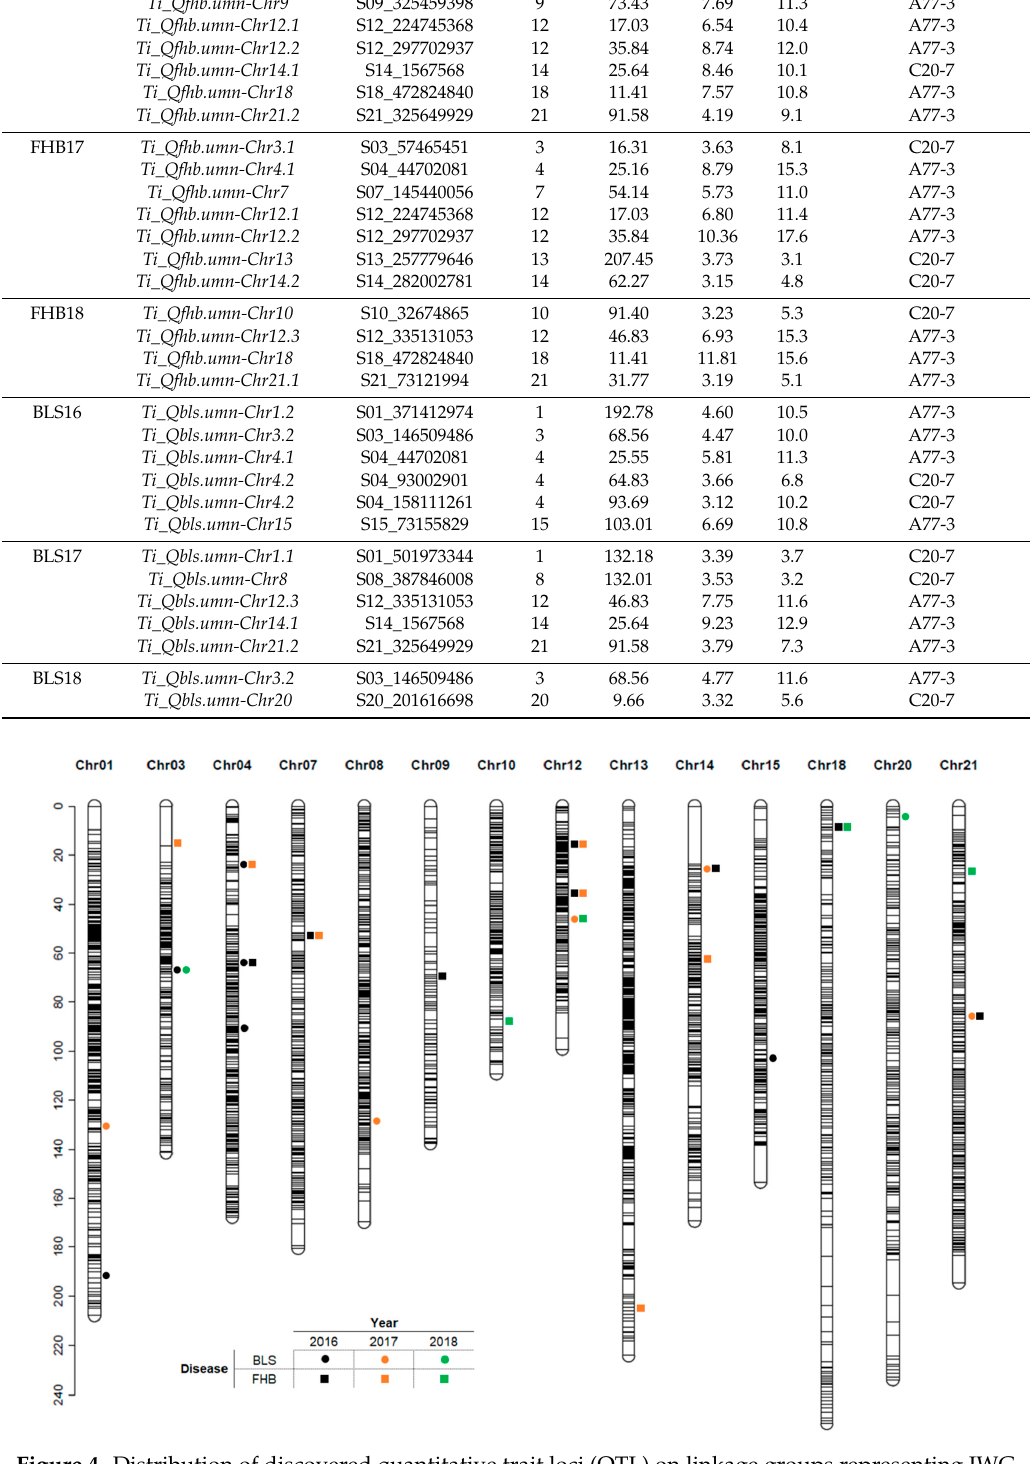
Figure 4. Distribution of discovered quantitative trait loci (QTL) on linkage groups representing IWG chromosomes; only the chromosomes with QTL detected are displayed. Ruler on the left shows the map length in centiMorgans (cM). Horizontal bars indicate SNP markers. Table 3. Quantitative trait loci (QTL) for Fusarium head blight and bacterial leaf streak detected in the A77-3 × C20-7 IWG population.